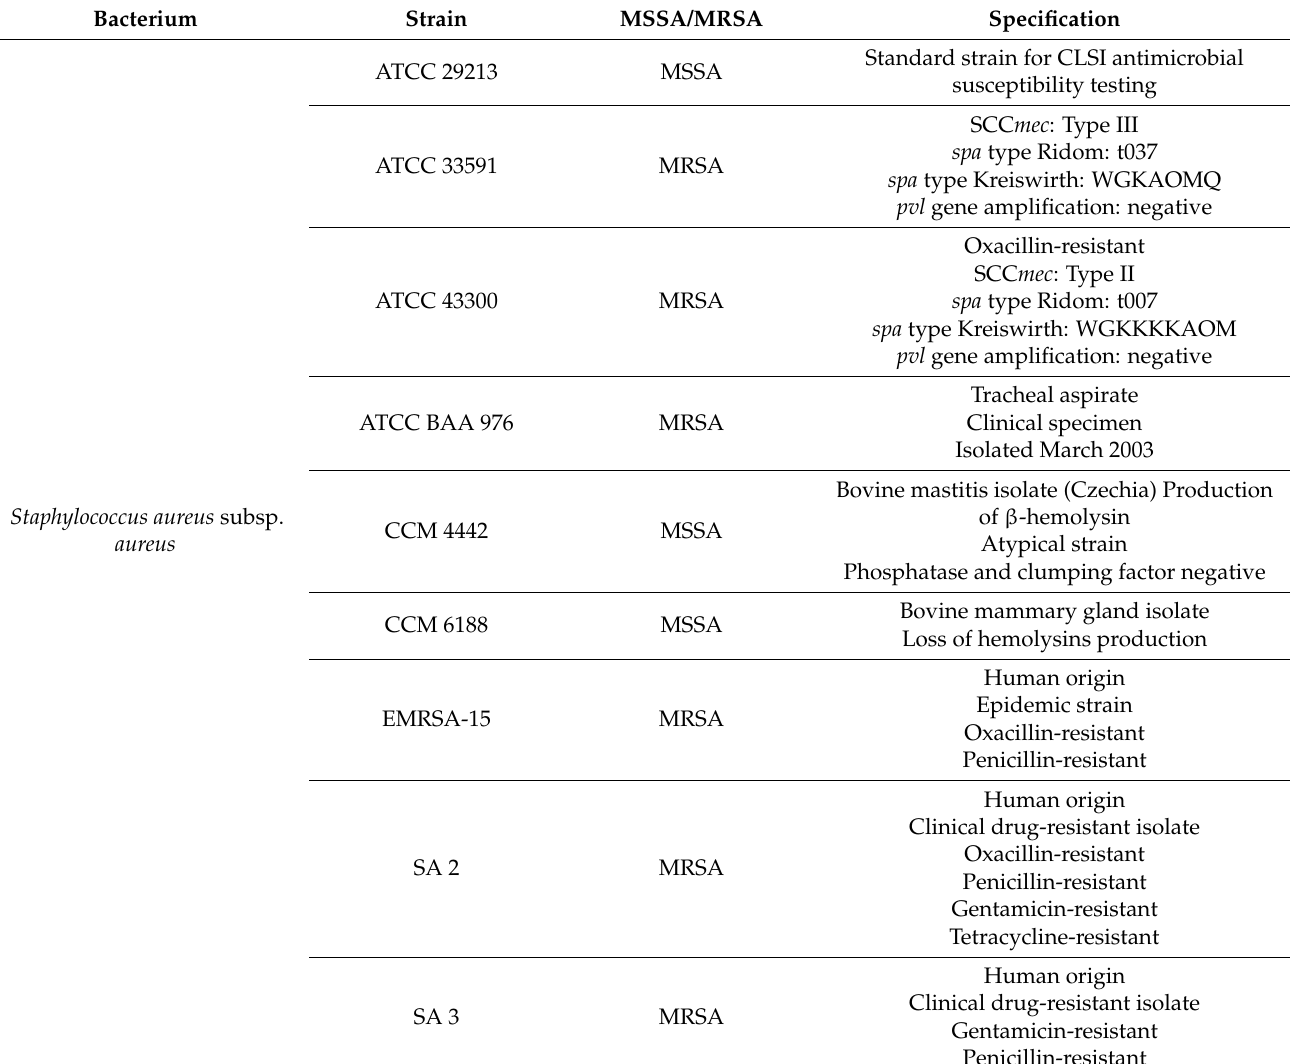
Table 1. Bacterial strains and their